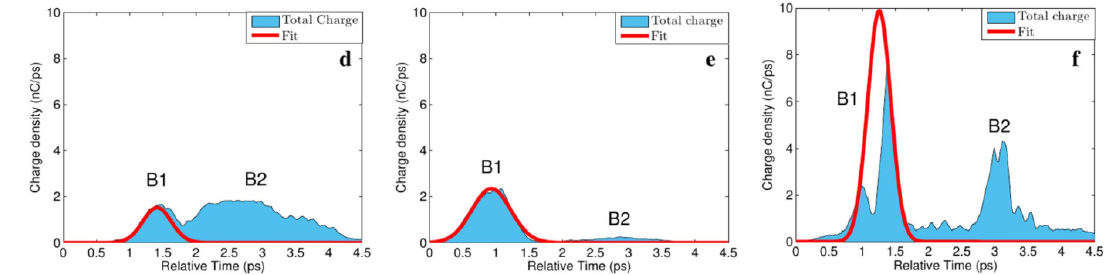
Figure 6. Snapshots with different target shapes. Snapshots of the escaping electrons from ( a ) planar; ( b ) wedged and ( c ) tipped targets. The emitted charges are: ( a ) 1.2 nC (B1) and 3 nC (B2); ( b ) 2 nC (B1) and 0.3 nC (B2); ( c ) 7 nC (B1) and 3 nC (B2); ( d – f ) corresponding longitudinal charge profiles. The Gaussian envelopes represent the extrapolated charge profiles of each bunch